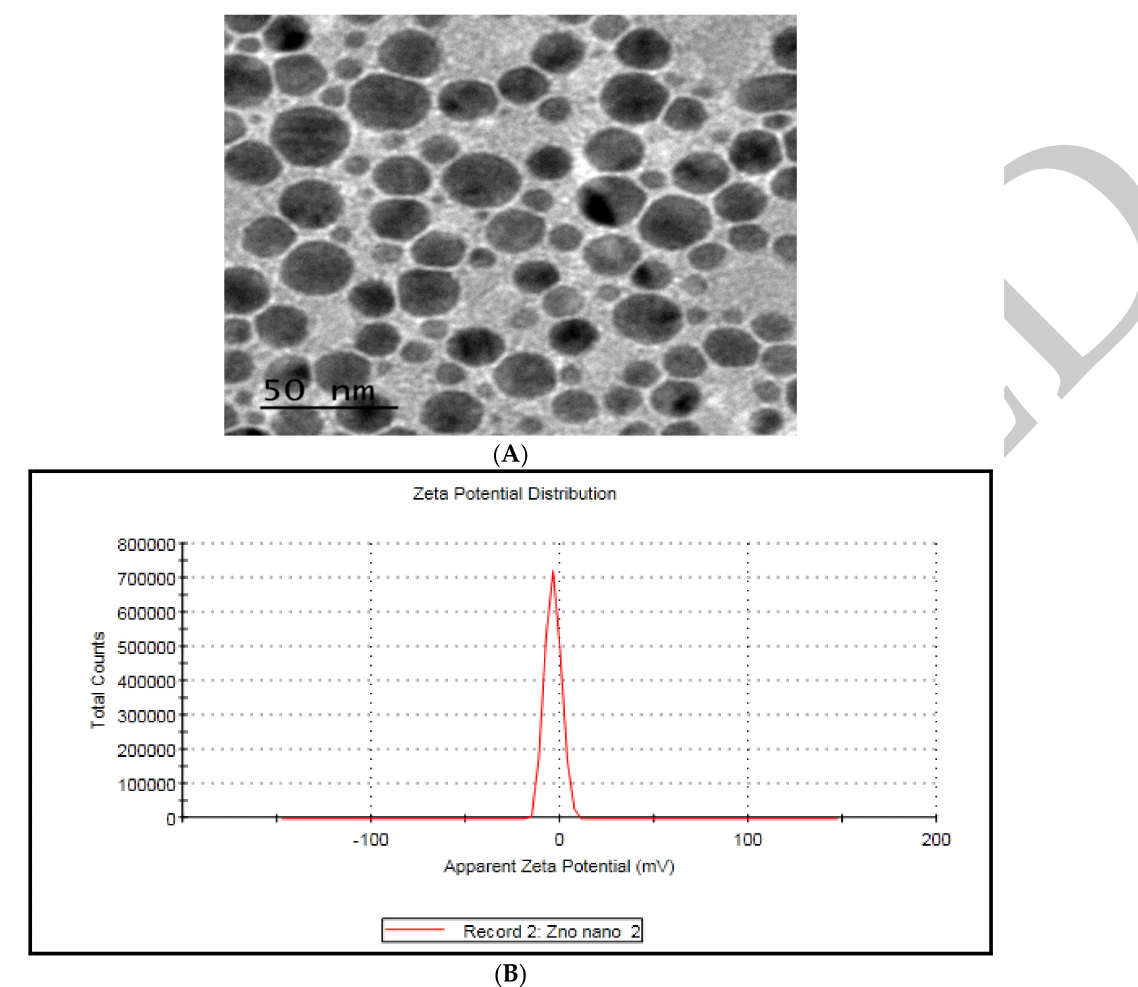
Figure 2. Transmission electron microscope (TEM) and Zeta potential of Chitosan nanoparticles: ( A ) TEM characterization for chitosan nanoparticles; ( B ) Zata potential for Chitosan